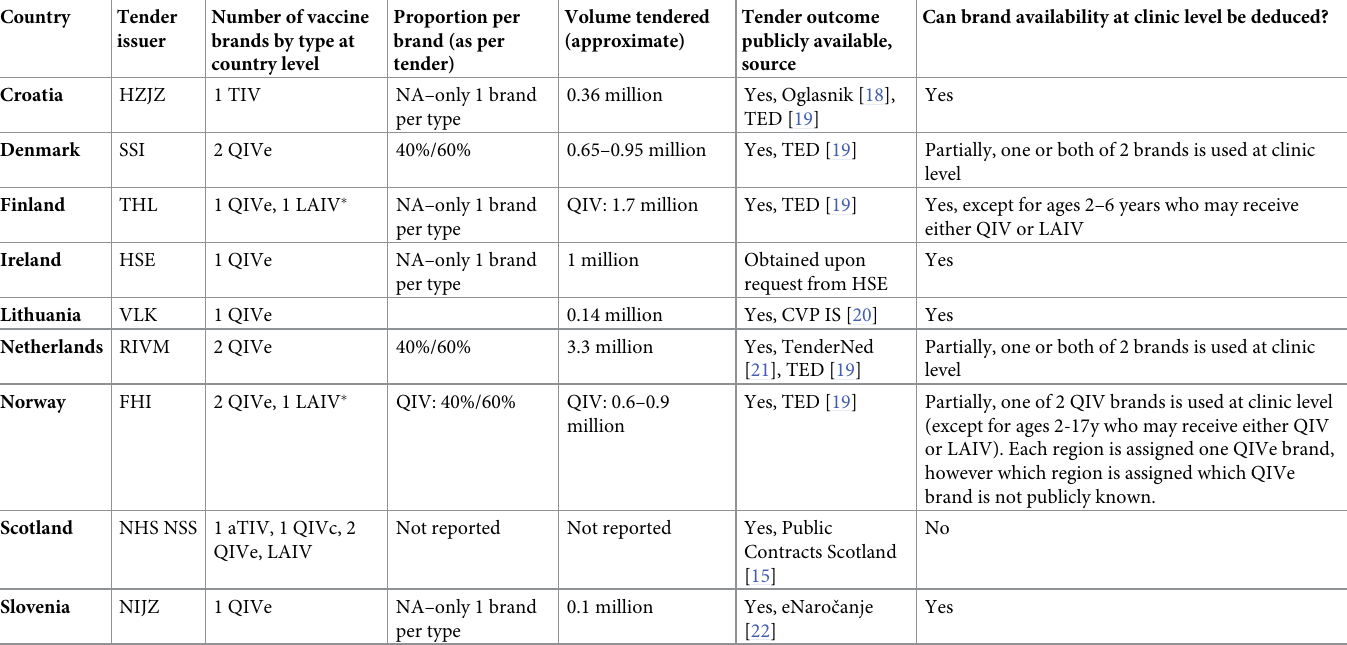
Table 1. Vaccines types and number of brands procured through national public tenders (2019–2020